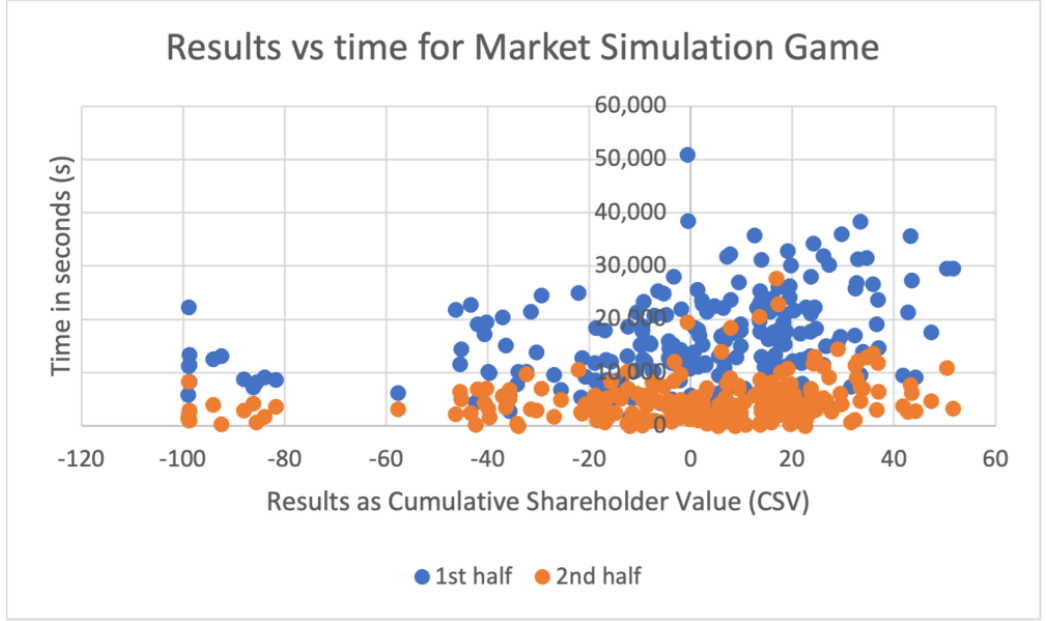
Figure 5. Scatter plot of result at end of round 4 (x) vs time logged in the two halves of the market simulation game